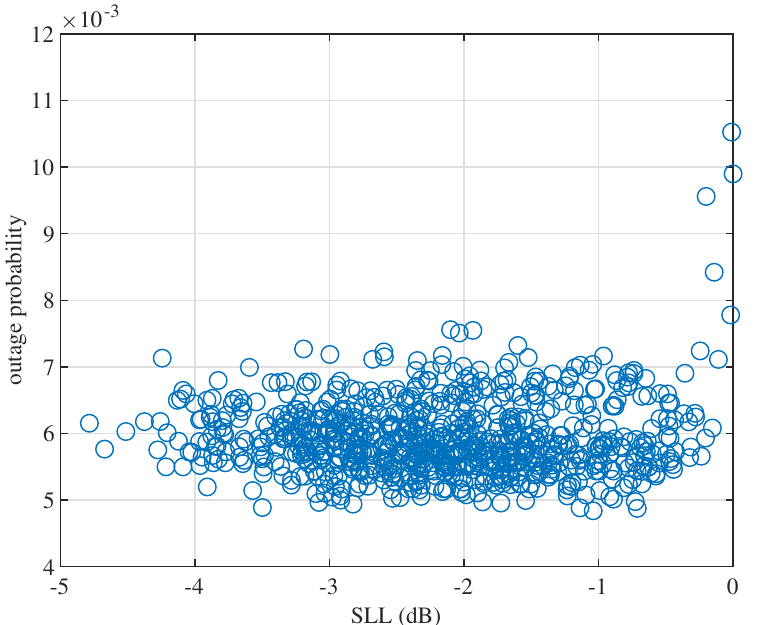
Figure 6. Scatter plot of 800 different random arrays showing only a small correlation between the SLL and the outage probability. The SLL is found when the array is uniformly